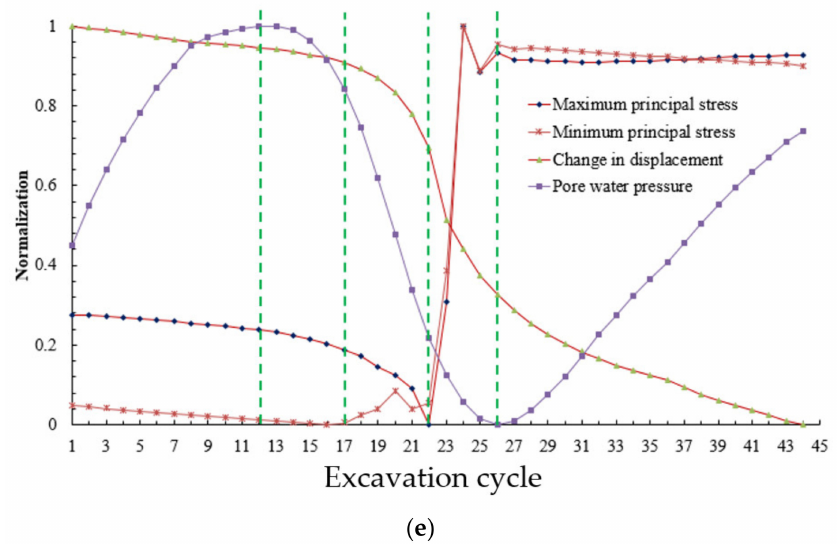
Figure 11. Variation curves of multivariate information at monitoring point 1-1 of monitoring section III. ( a ) Time history of maximum principal stress; ( b ) Time history of minimum principal stress; ( c ) Time history of displacement in the Y direction; ( d ) Time history of seepage pressure; ( e ) Normalization curves of linear functions.